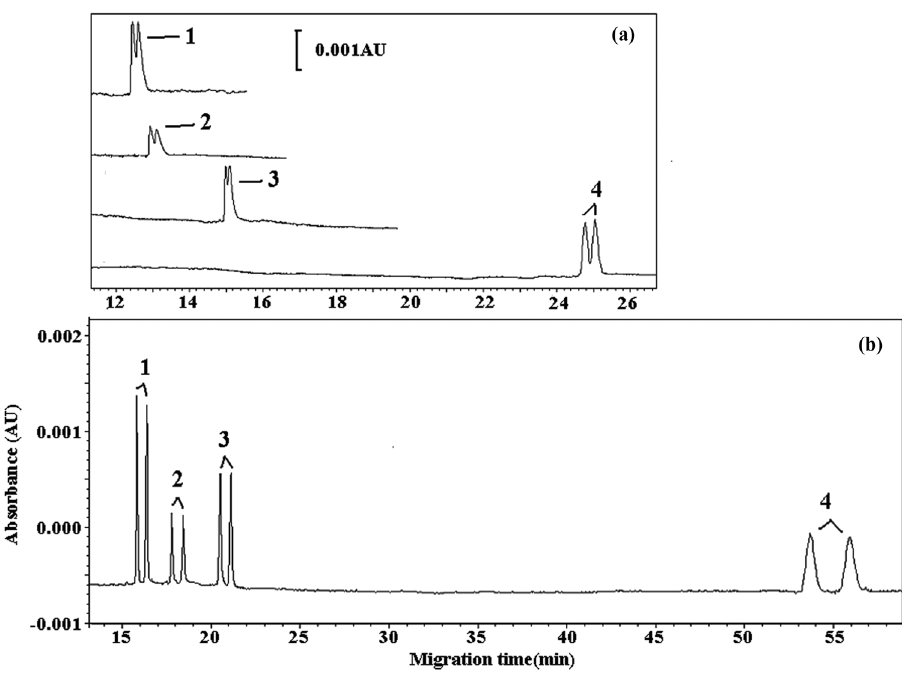
Figure 3: Electropherograms of four azole antifungal enantiomers: ( 1 ) miconazole; ( 2 ) econazole; ( 3 ) ketoconazole; ( 4 ) itraconazole. ( a ) BGE with HP - β - CD, ( b ) BGE with HP - β - CD/DTAC ( CIL ) . Reprinted from ref. [ 98 ]